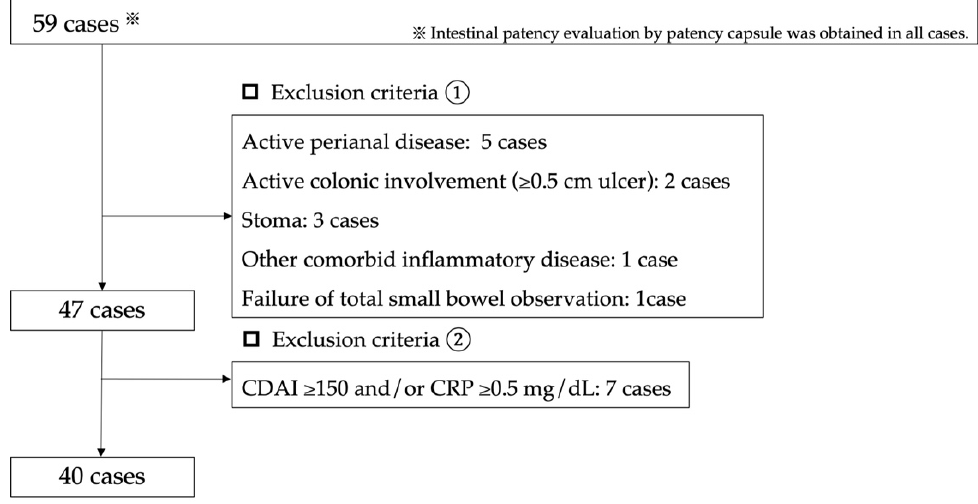
Figure 1. Study profile.